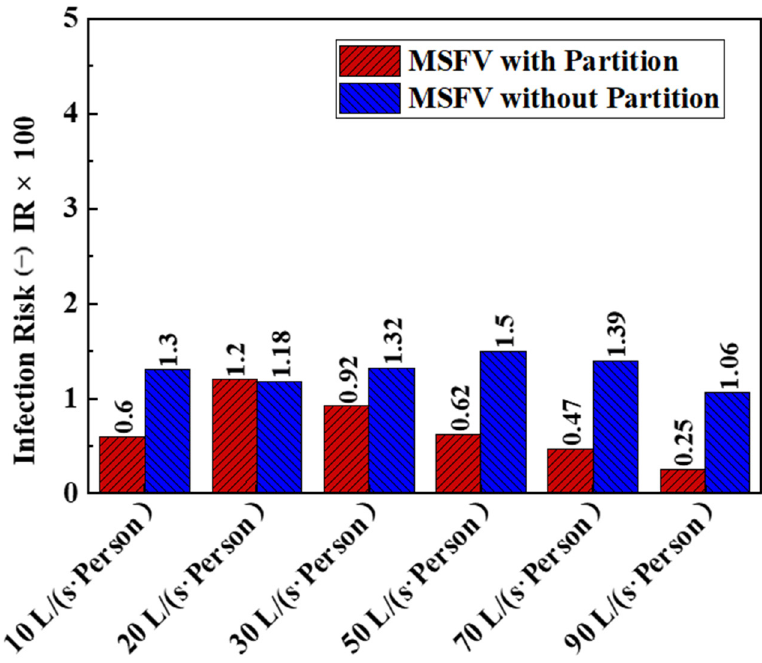
Figure 17. Infection risk to medical staff wearing N95 masks under the MSFV, with and without partition.